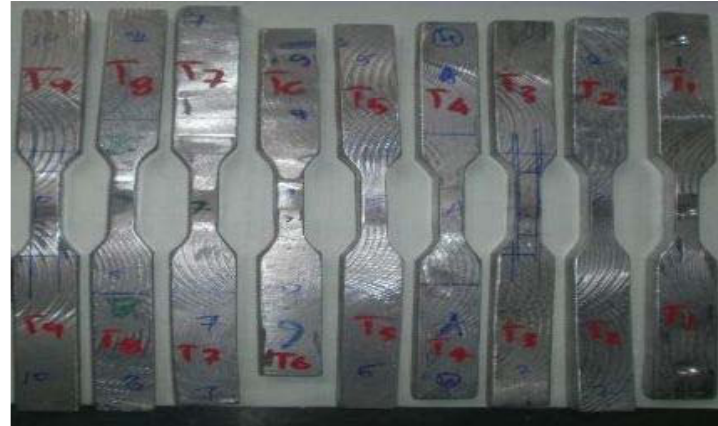
Figure 2. Tensile test samples as per ASTM Standards. Table 5. Tensile test results.